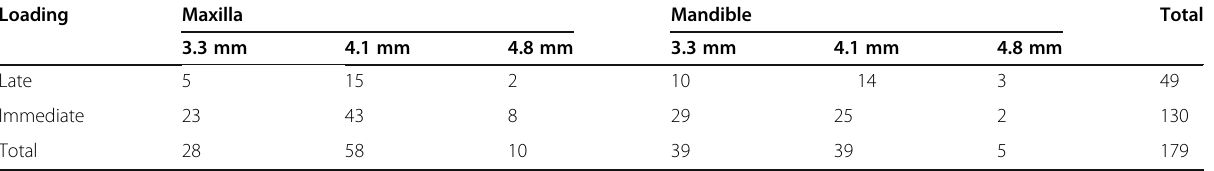
Table 1 Implant distribution according to implant diameter and loading protocol